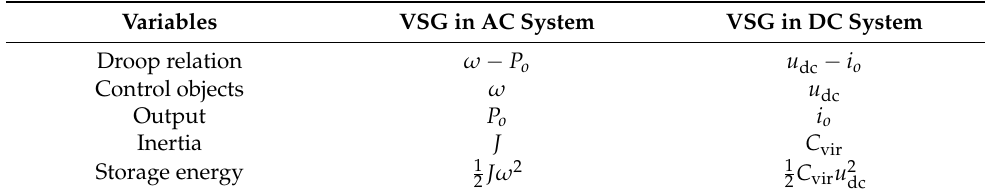
Table 1. VSG analogy between ac system and dc system. Variables VSG in AC System VSG in DC System Droop relation ω − P o u dc − i o Control objects ω Inertia Storage